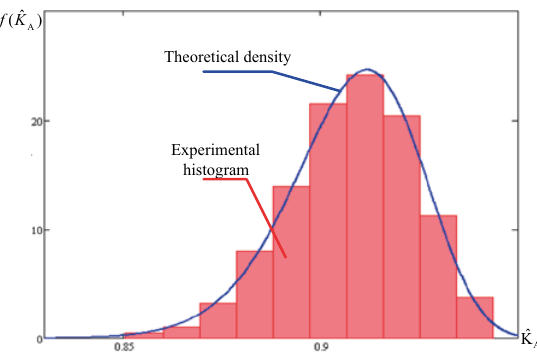
Fig. 4. PDF and histogram of the ready-to-operate factor estimation for the case of exponential distribution of the operating time between failures and recovery time